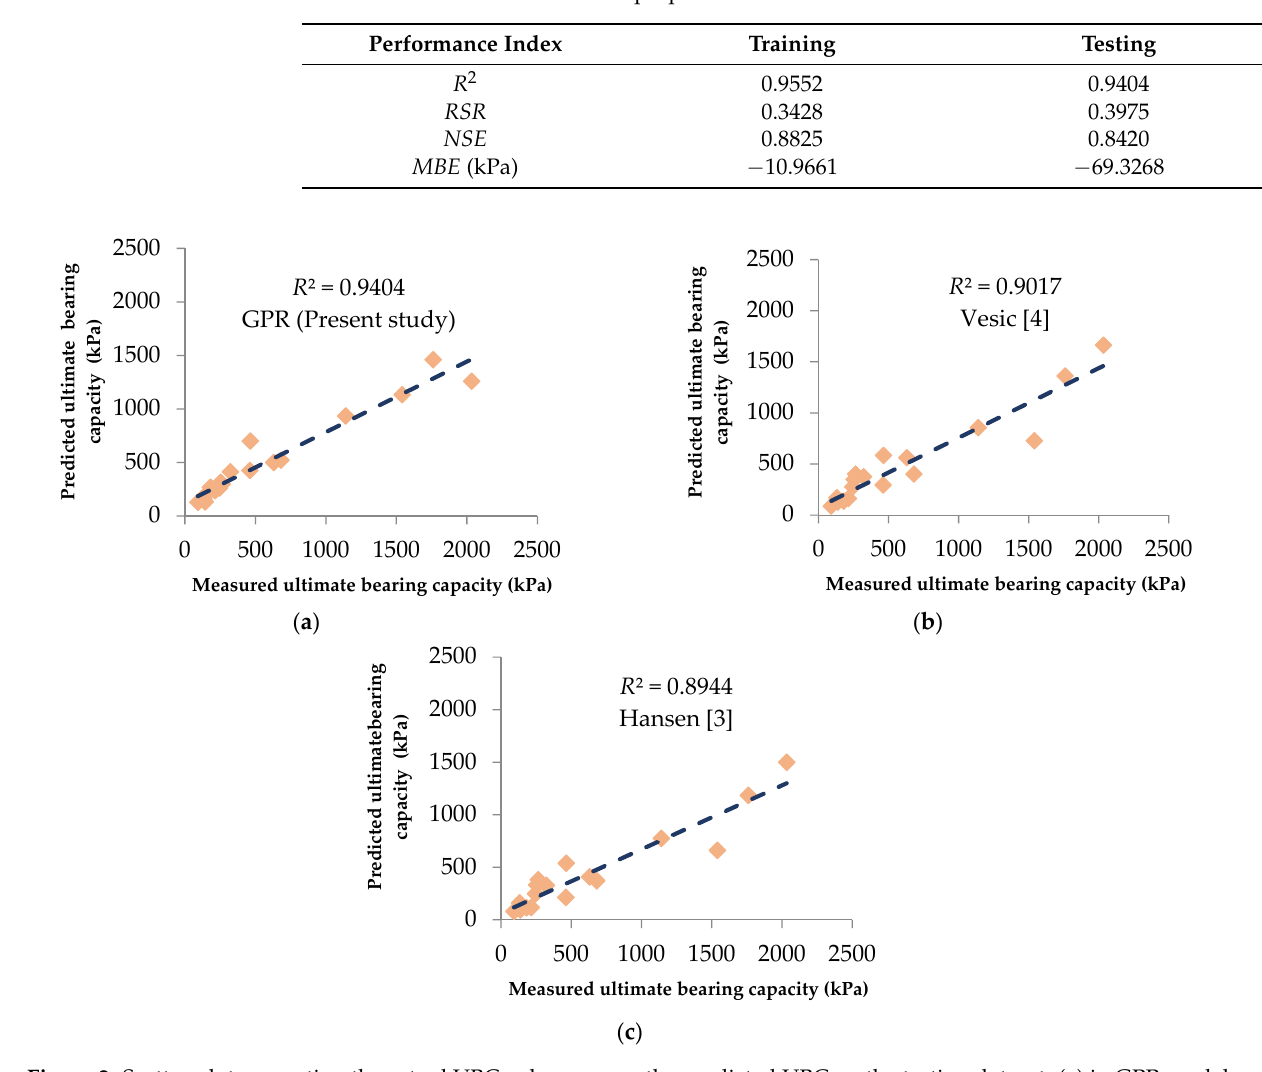
Table 4. Performance statistics of proposed model.